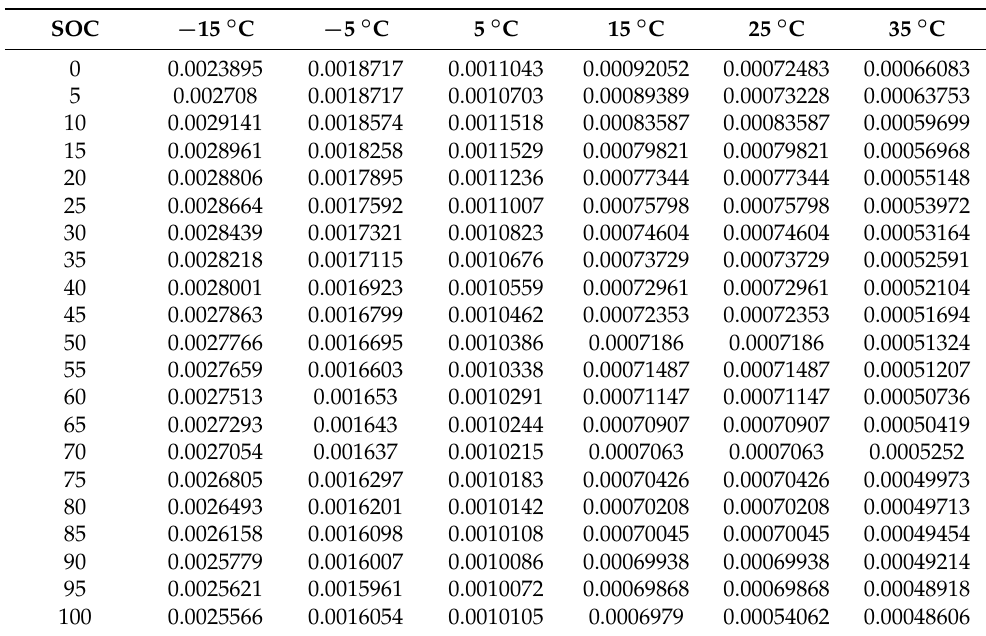
Table A5. Values for parameter R ser in Ω of electrical model shown in Figure 2 in dependence of cell temperature and